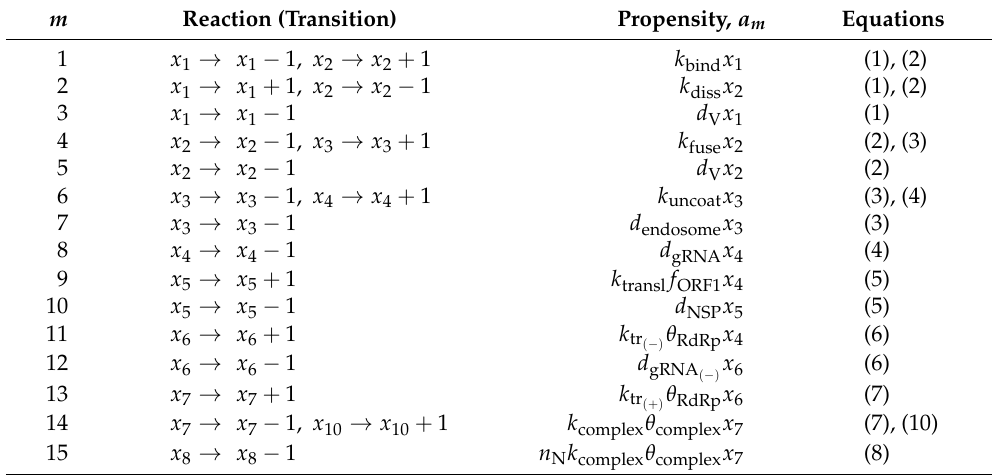
Table 2. The Markov chain: the list of individual reactions, the corresponding state transitions, and the propensities of